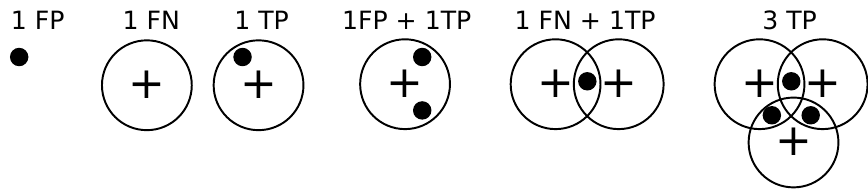
Figure 9. Illustration of true positives, false negatives and false positives. + are ground truth annotations, • are detections and ◦ are disks of radius r around ground truth